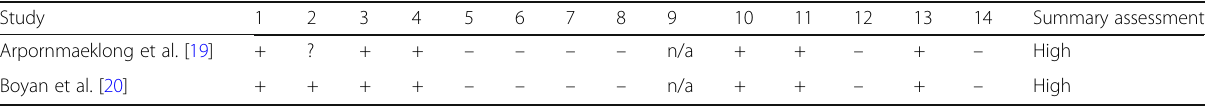
Table 1 Quality assessment of in vitro studies according to the items of the Modified CONSORT checklist [16] Study 1